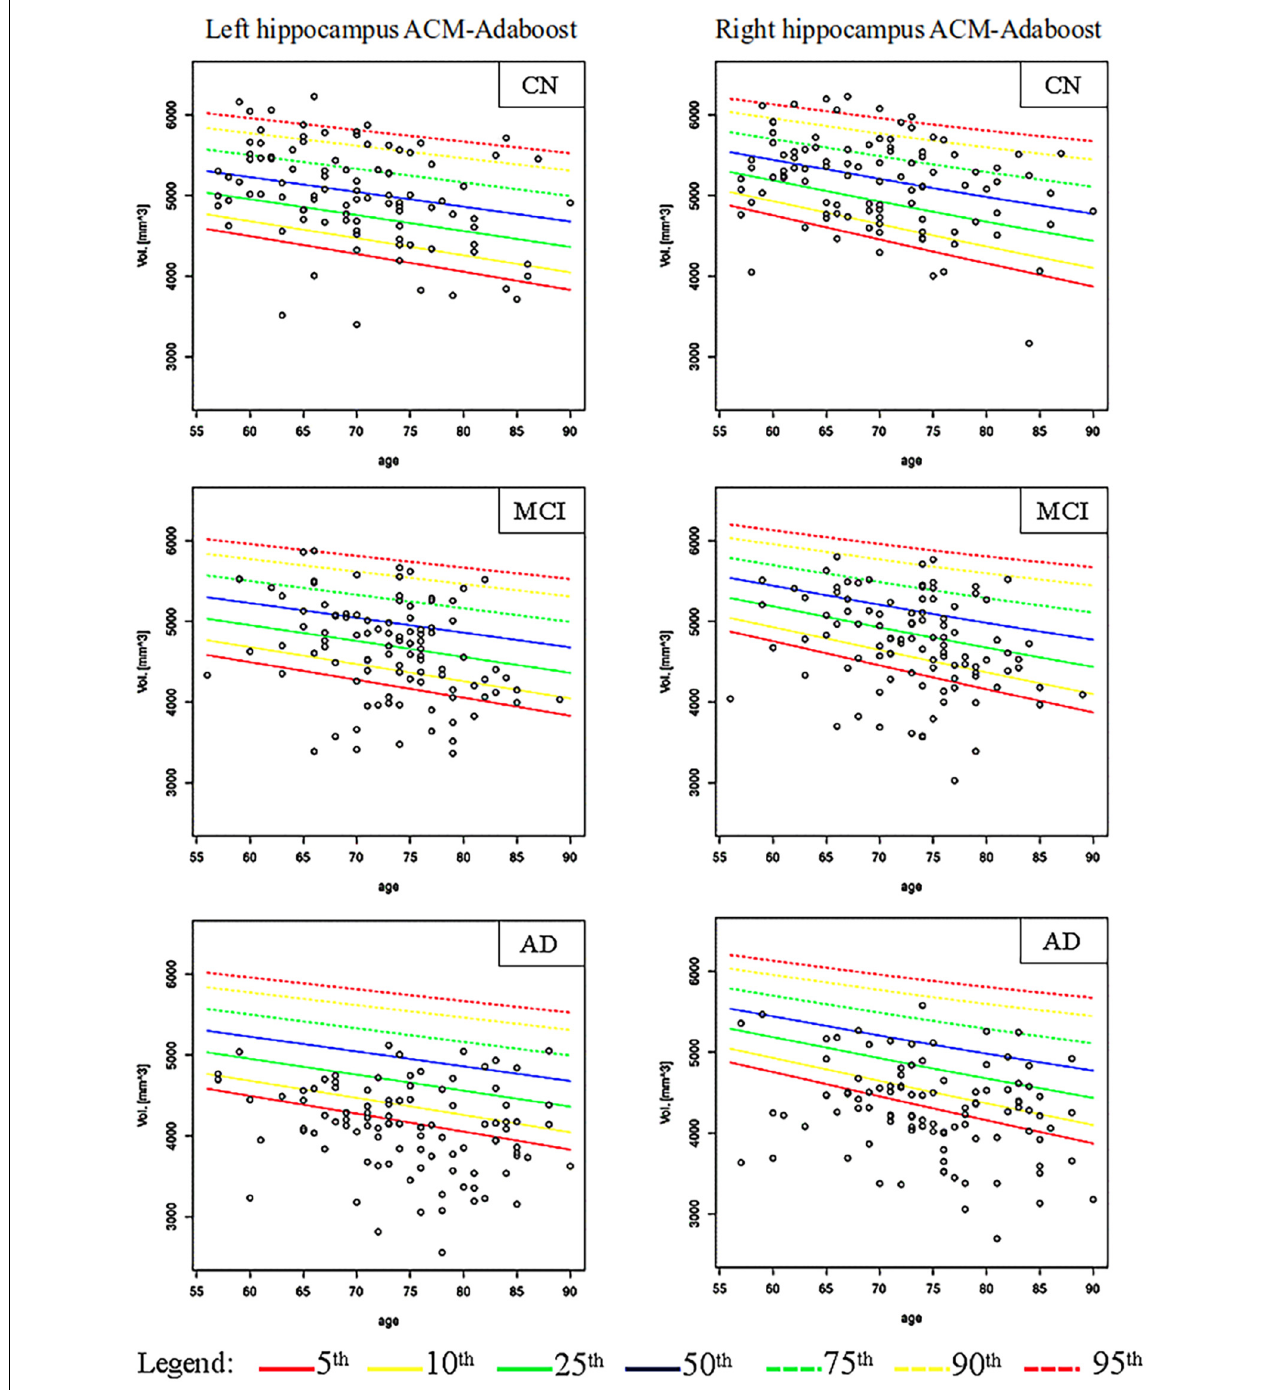
FIGURE 3 | Age-specific percentile distribution of ARWiBo hippocampal volumes processed with AA. Left and right scatter plots of ARWiBo hippocampal volumes (mm 3 ) (100 CN, 100 MCI, 100 AD) from 56 to 90 years on the ADNI percentiles chart. CN, cognitively intact healthy Control; MCI, Mild Cognitive Impairment; AD, Alzheimer’s